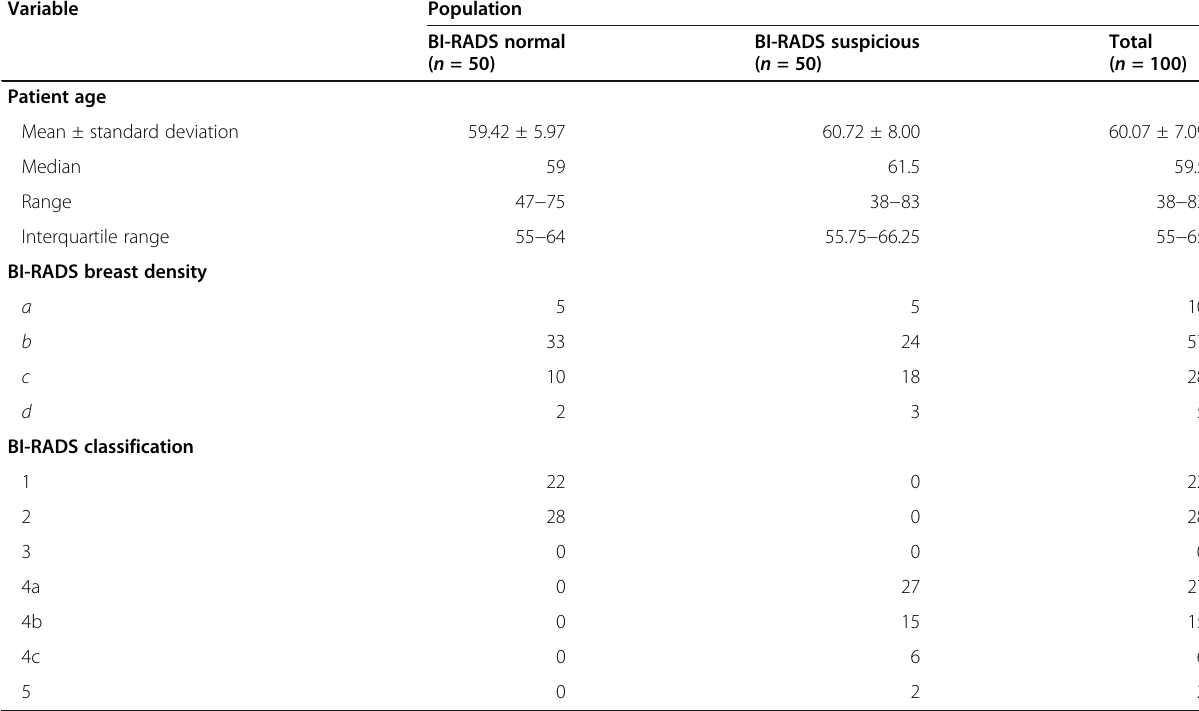
Table 1 Characteristics of the population and digital mammography examinations selected for the study Variable